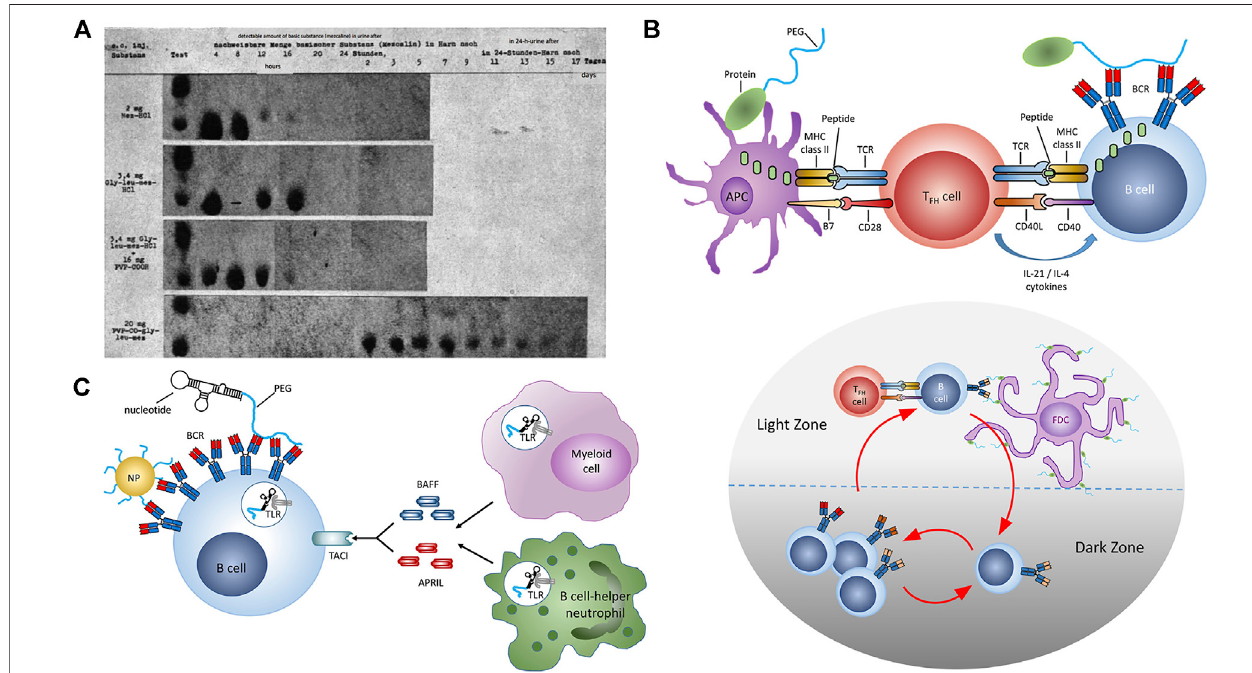
FIGURE 1 | Polymer-Drug Conjugates: Inception to Immunology. (A) Renal excretion of mescaline and equimolar dosages of mescaline-PVP conjugate as measuredbychromatographyofurinaryextractsobtainedfollowings.c.adminisrationinwhitemicecirca1955. (B) Thymus-dependentimmuneresponseagainstPEG. (upper panel) TFH activation following antigen presentation by APCs. Somatic hypermutation and class switching in B cells following antigen encounter and interaction with activated TFH cells. (lower panel) Af fi nity maturation of PEG-speci fi c B cells in the spleen. (C) Thymus-independent immune response against PEG. Crosslinking of BCRs by PEG and coactivation of TLRs. Reproduced with permission from Reproduced with permission from (A) Luxenhofer, 2020 and (B,C) Chen et al., 2021. Copyright (A) 2020 de Gruyter GmbH and (B,C) 2021 American Chemical Society.